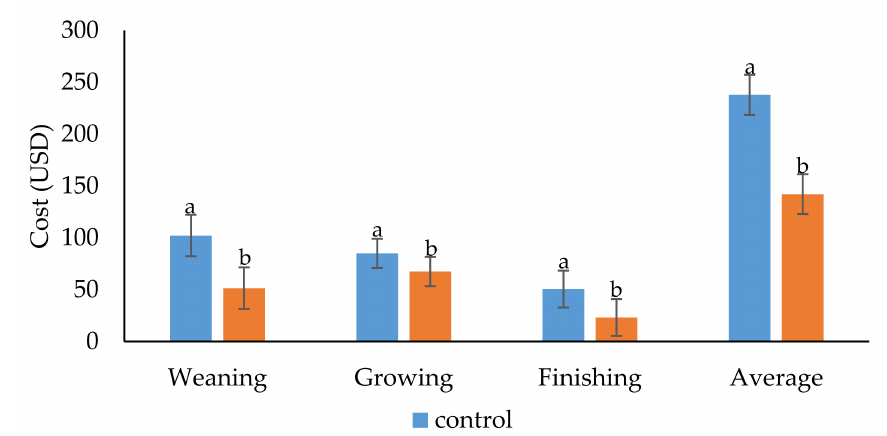
Figure 6. The e ff ect of the geothermal heat pump (GHP) on the cost of electricity during the weaning, growing, and finishing period. a,b Bars at a particular point with di ff erent alphabet di ff er significantly ( p <